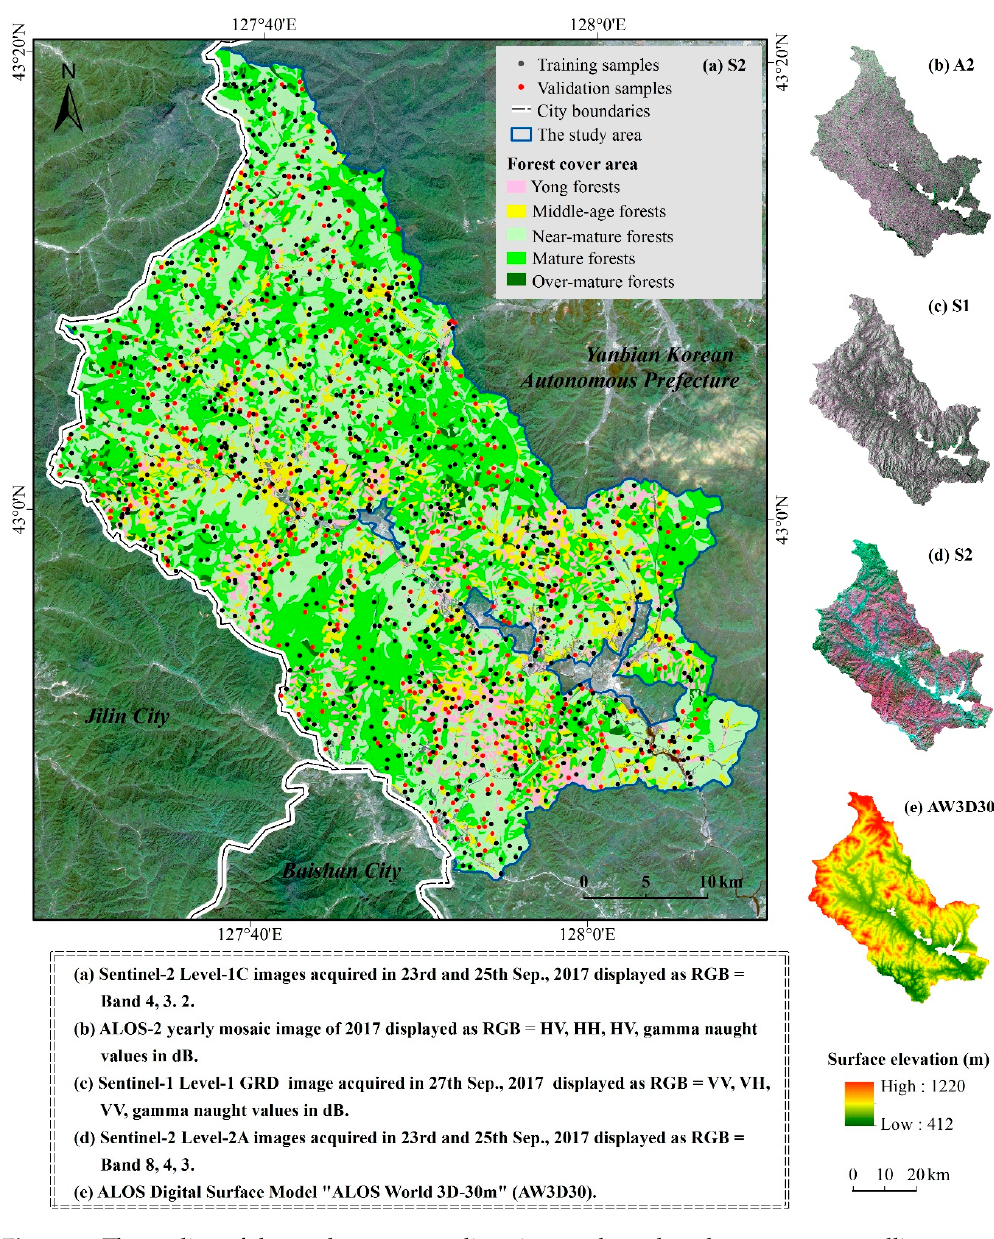
Figure 1. The outline of the study area, sampling sites, and employed open-access satellite remote sensing data derived from Advanced Land Observing Satellite (ALOS), ALOS-2, Sentinel-1, and Sentinel-2 series. Date include ( a ) Sentinel-2 Level-1C, ( b ) ALOS-2 yearly mosaic, ( c ) Sentinel-1 Level-1 GRD, ( d ) Sentinel-2 Level-2A, and ( e ) ALOS Digital Surface Model products. The field campaign was carried out in September 2017. Stratified sampling design was used by masking non-forest areas and randomly generating the distribution of sampling plots in forest areas, while the plots that were impossible to access were replaced by the nearest sites. Following the national guidelines for forest resource survey [46], eight teams took part in collecting measured data under the same protocol. A total of 1392 squared 30 m by 30 m samples were established (Figure 1a). At each sample site, tree species, diameter at breast height (DBH, the diameter at 1.3 m from the ground), and tree height were measured and recorded. Age classes from young to over-mature were acquired from the forest manager’s archives at the local forestry bureau for further analysis (Figure 1a).